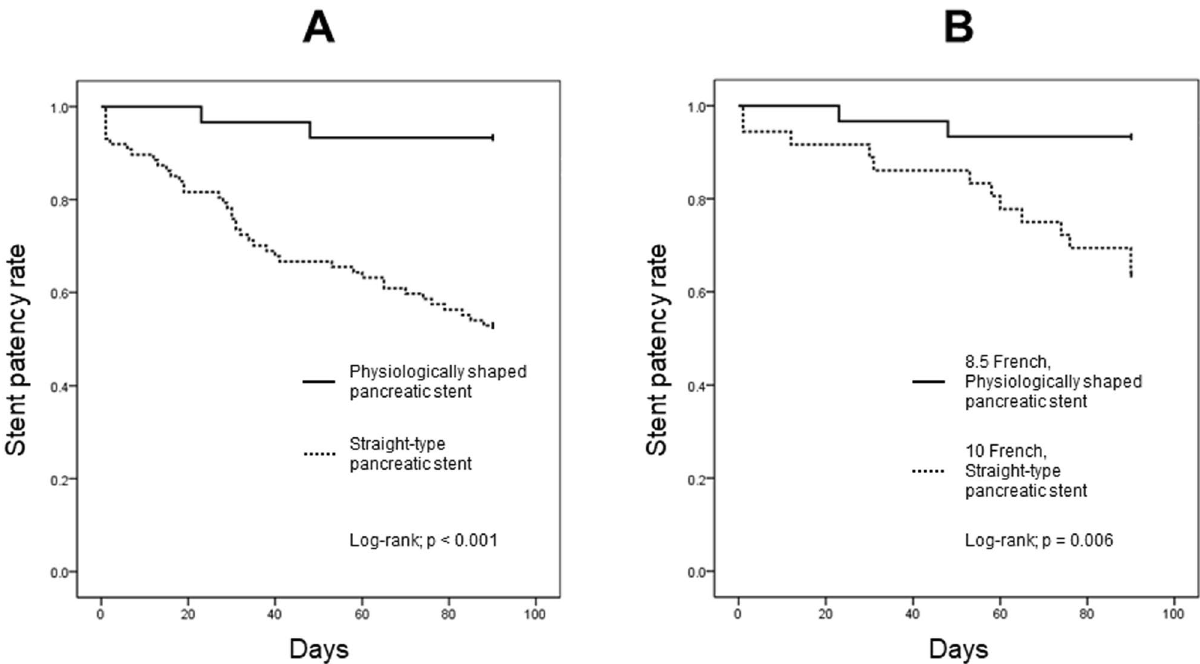
Figure 1. Kaplan–Meier plots of time to stent dysfunction according to stent shape. A log-rank test showed that time to stent dysfunction was significantly longer in the physiologically shaped pancreatic stent group